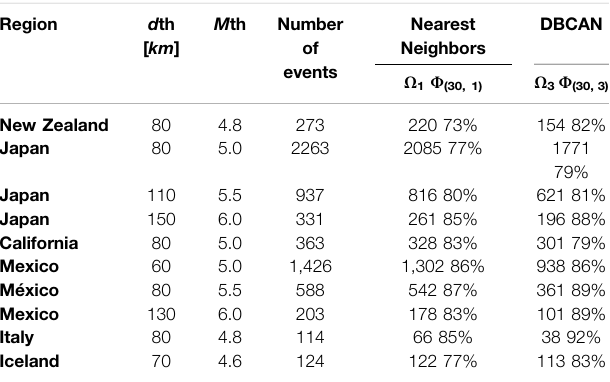
TABLE 2 | Results of the methodology proposed in this work: d th is the neighborhood radius size in kilometers; M th the minimum magnitude considered in the study; Number of events the total number of earthquakes with a magnitude larger or equal than M th; Ω 1 and Ω 3 are the number of events with at least one or three neighbors inside the sphere of radius d th respectively; and Φ ( Φ ( 30 , Ω 1 ) and 30 , Ω 3 ) depicts the percentage of events with at least one solution with a Φ < 30 computed from the Statistical method or DBSCAN algorithm respectively.